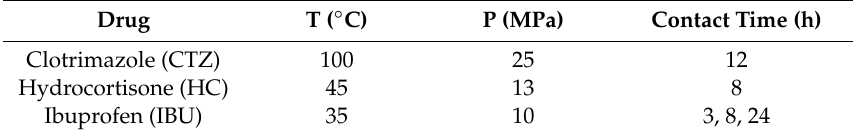
Table 2. Working conditions of the SSI for the di ff erent mesoNsZnO drug systems. Drug T ( ◦ C) P (MPa) Contact Time (h) Clotrimazole (CTZ) 100 25 12 Hydrocortisone (HC) 45 13 8 Ibuprofen (IBU) 35 10 3, 8,